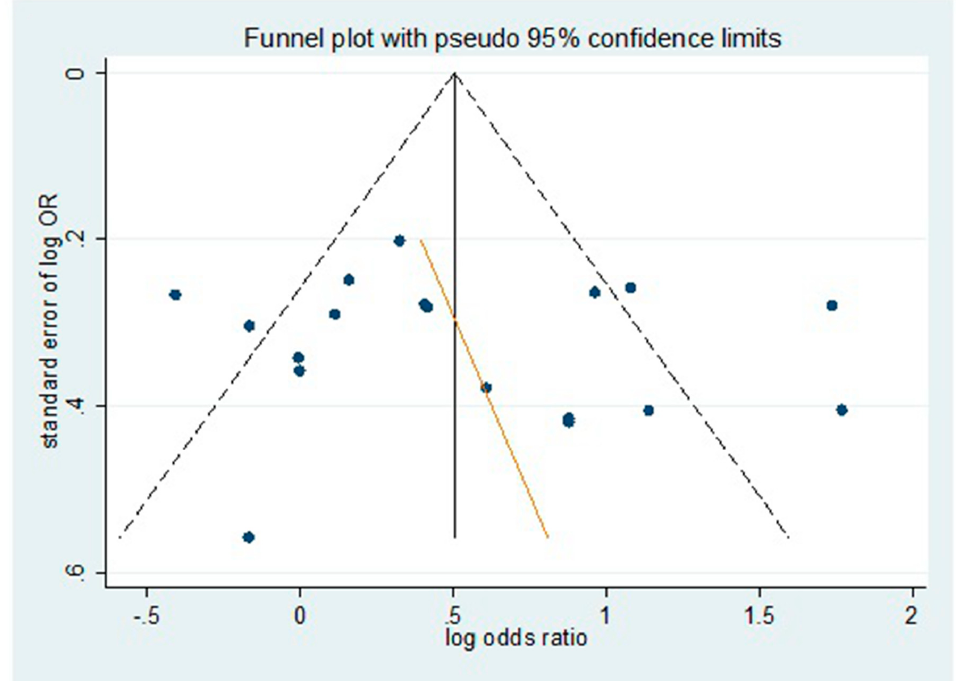
Figure 3. Evaluation of publication bias for all studies using funnel plots. No significant funnel asymmetry was observed which could indicate publication bias. Table 4. The results of publication bias test by Egger and Begg